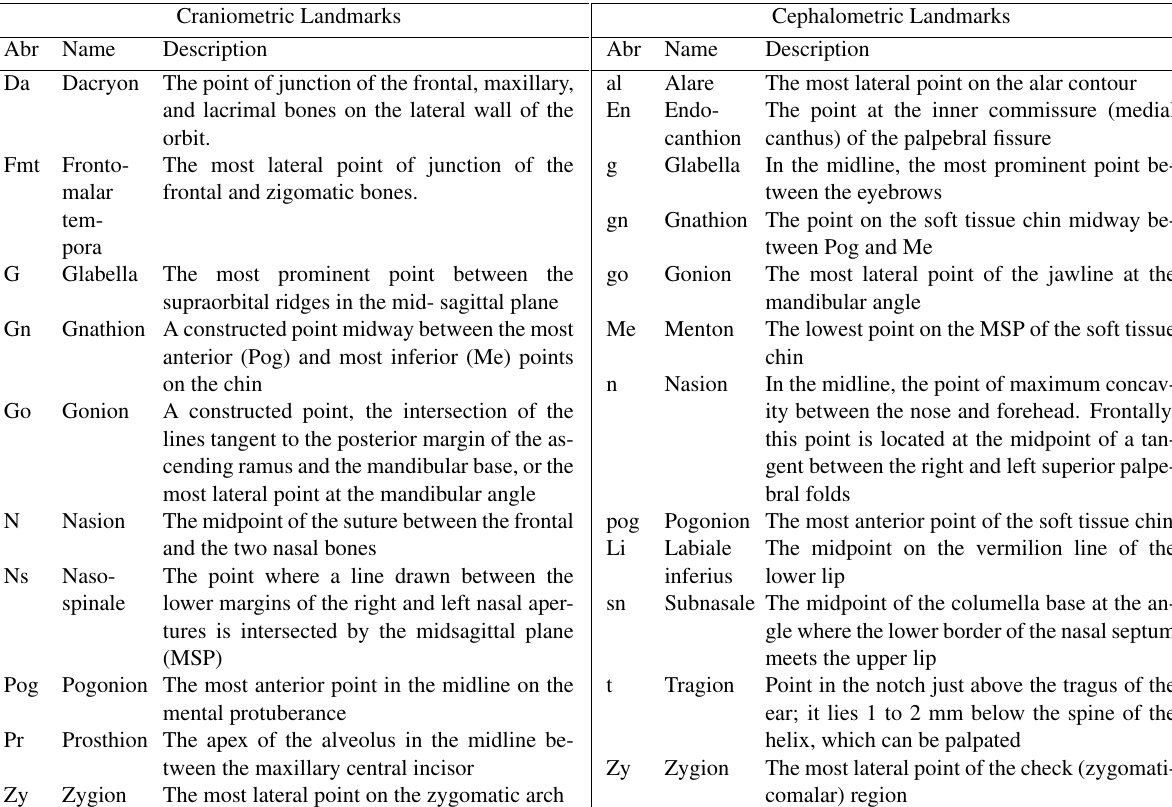
Figure 2. Cephalometric